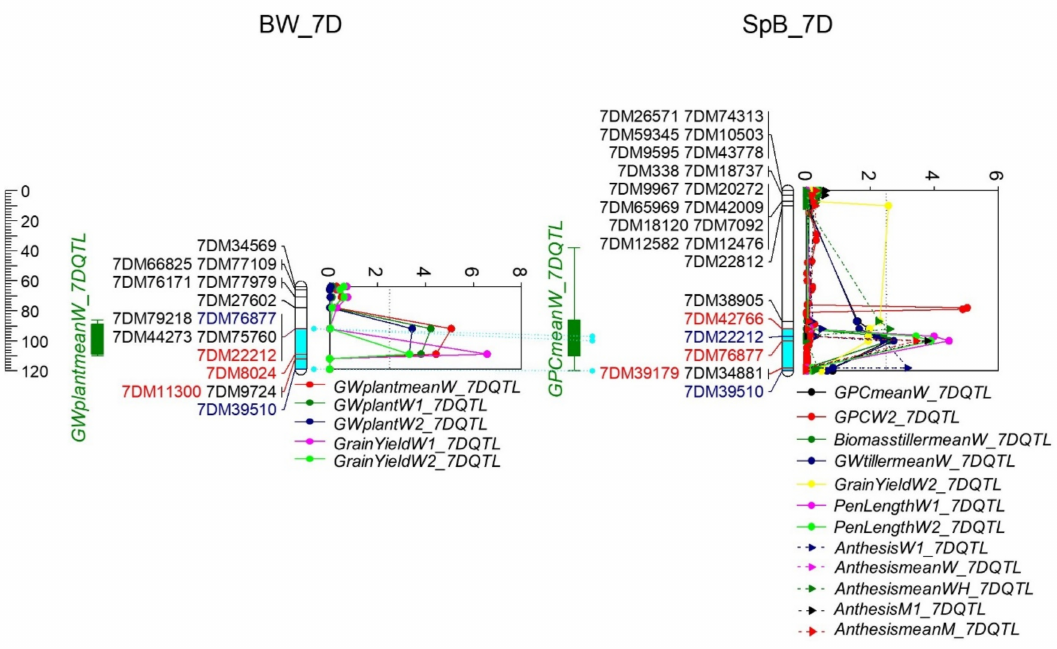
Figure 10. Significant QTL formed one QTL cluster on the homologous region on 7D in both populations, BW and SpB. Homologous regions in both populations are highlighted in light blue; markers for QTL highlighted in red; homologous markers highlighted in